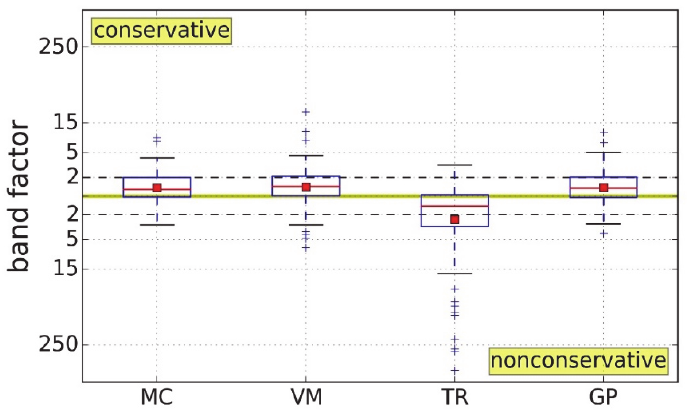
Figure 3: Box chart of prediction differences: MC – middle curve, VM – von Mises, TR – Tresca, GP – Gough-Pollard.